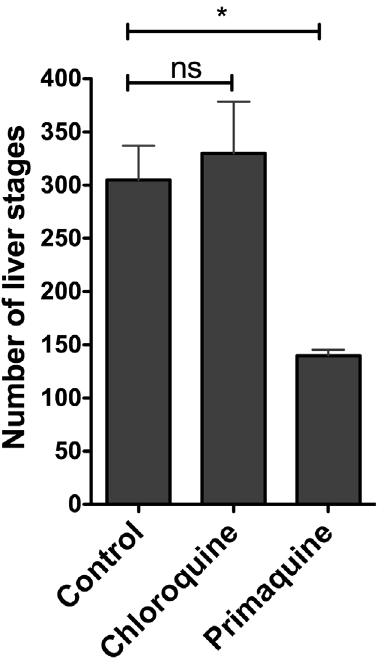
Figure 1. CQ has no effect on Plasmodiumberghei liver-stage numbers invitro . 10,000 P. berghei NK65 sporozoites were allowed to invade HuH7 cells and subsequently cultured in DMEM culture medium (with 10% FCS and 1% Penicillin/Streptomycin) alone or supplemented with 10 m M chloroquine or 10 m M primaquine. Parasites were permitted to develop over 48 hours before being fixed, stained with anti-HSP70